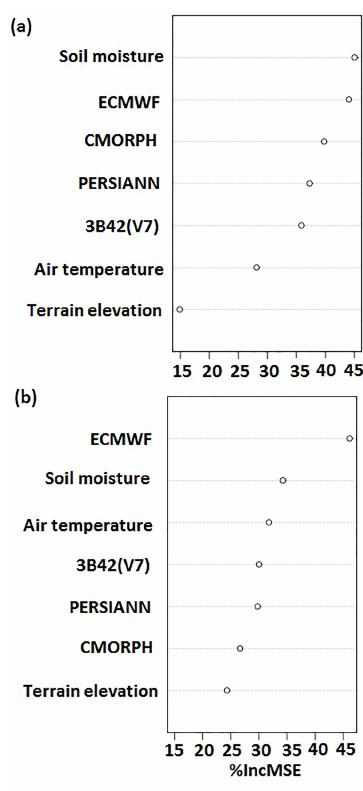
Figure 3. Variable importance plot, where %IncMSE is the percent- age increase in mean square error. (a) Warm period–high elevation. (b) Cold period–high